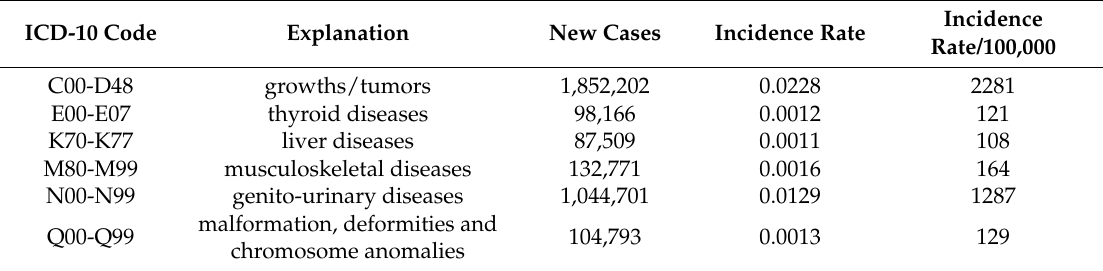
Table 2. Cases and incidence rates in total German population (81.2 million people)